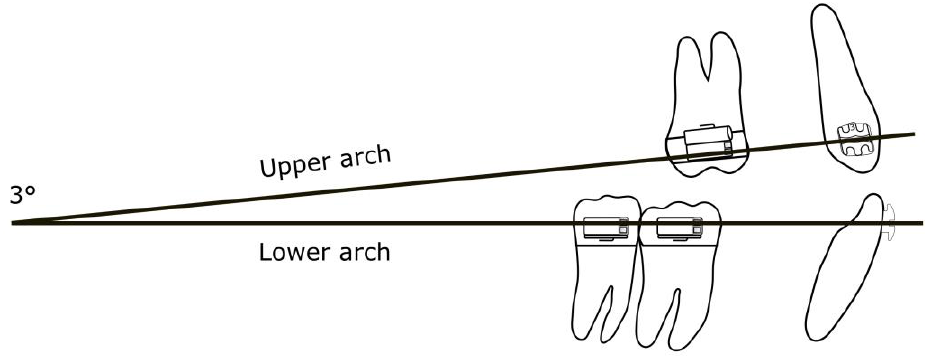
Figure 3. Degrees of mouth opening at rest position.